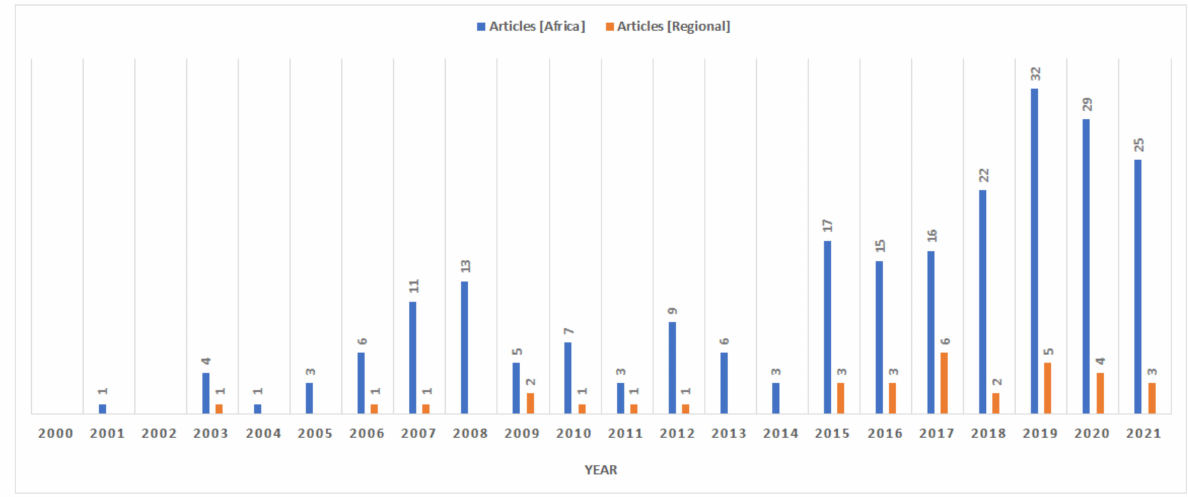
Figure 1. Annual publications from